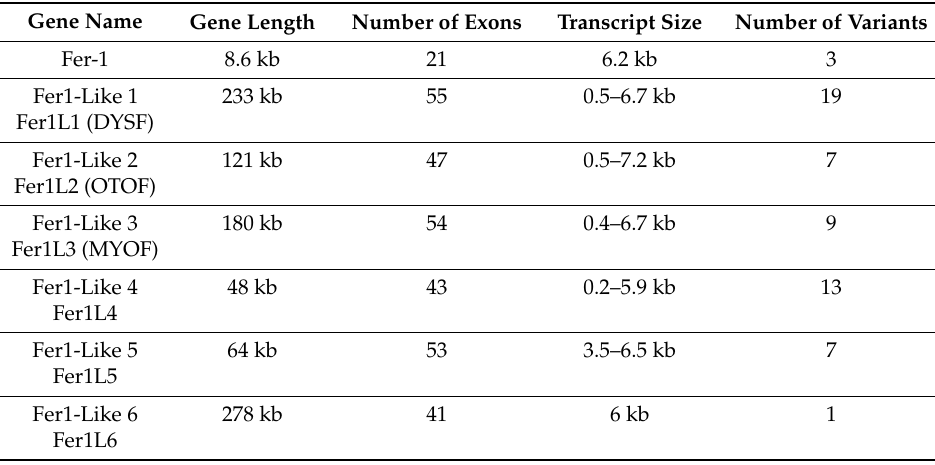
Table 2. Short description of C. elegans and human ferlin genes and